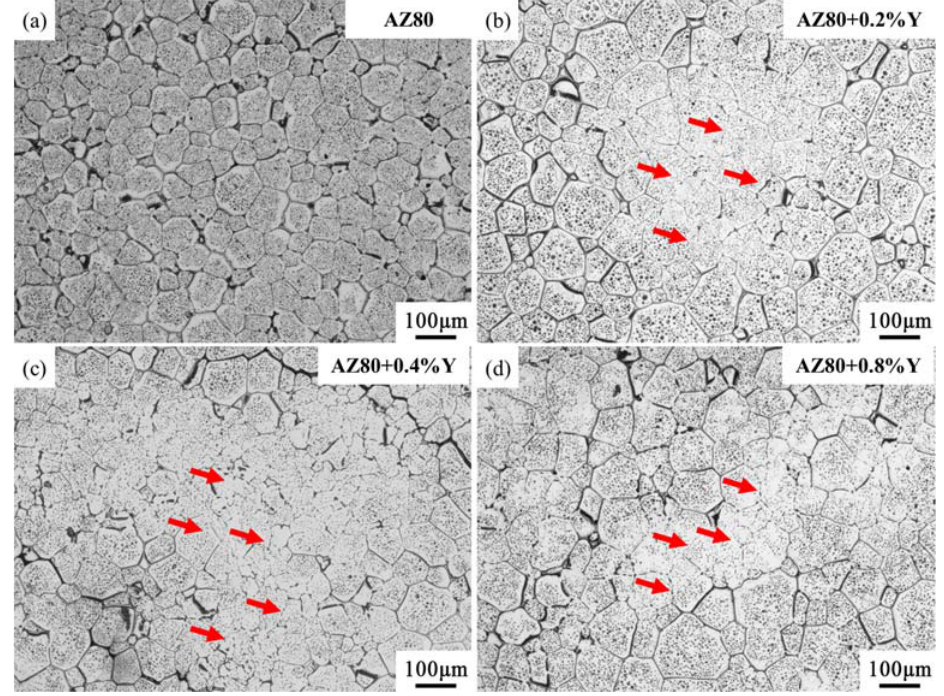
Figure 4. Microstructure evolution of alloys isothermally treated at 570 °C holding for 5 min: ( a ) AZ80; ( b ) AZ80M1; ( c ) AZ80M2; and ( d ) AZ80M3. (Inhomogeneous remelting regions are marked with the red arrows.)